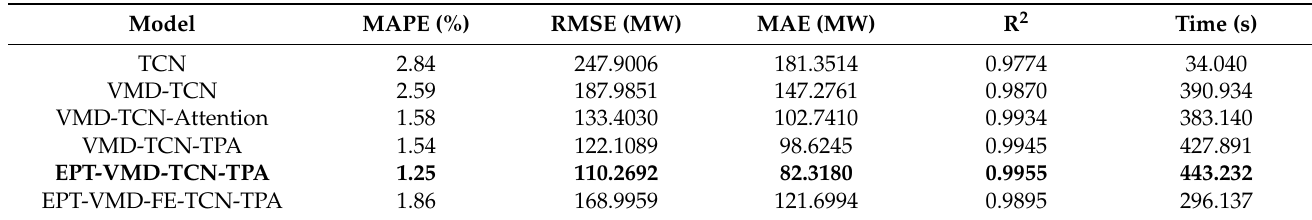
Figure 17. Area 1 ablation experiment prediction results. Table 8. Area 1 ablation model evaluation indicators. Table 8. Area 1 ablation model evaluation